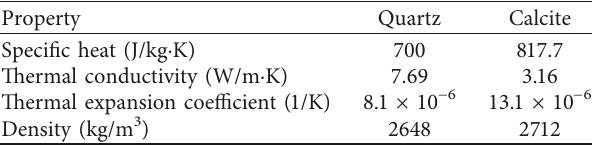
Table 3: Thermal input data for sand and